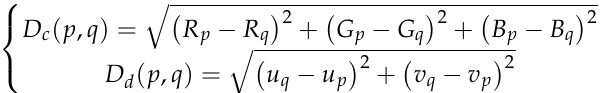
where S p is the corresponding segmentation units of the central pixel p , D c ( p , q ) , and D d ( p , q ) are the color difference and distance between the two points p , q , as shown in Equation (24), c 1 , c 2 are the threshold value of the set color difference, and c 1 < c 2 ; d 1 , d 2 are the threshold value of the distance set. When the distance between two pixels is very close, a slightly loose range of color difference is used to judge whether the two pixels belong to the same segmentation unit as the center pixel. When the distance increases, the color threshold is reduced. It is considered that only when the color is very close can they be recognized as belonging to the same segmentation unit. When the distance is too large, it is considered that they do not belong to the same unit.